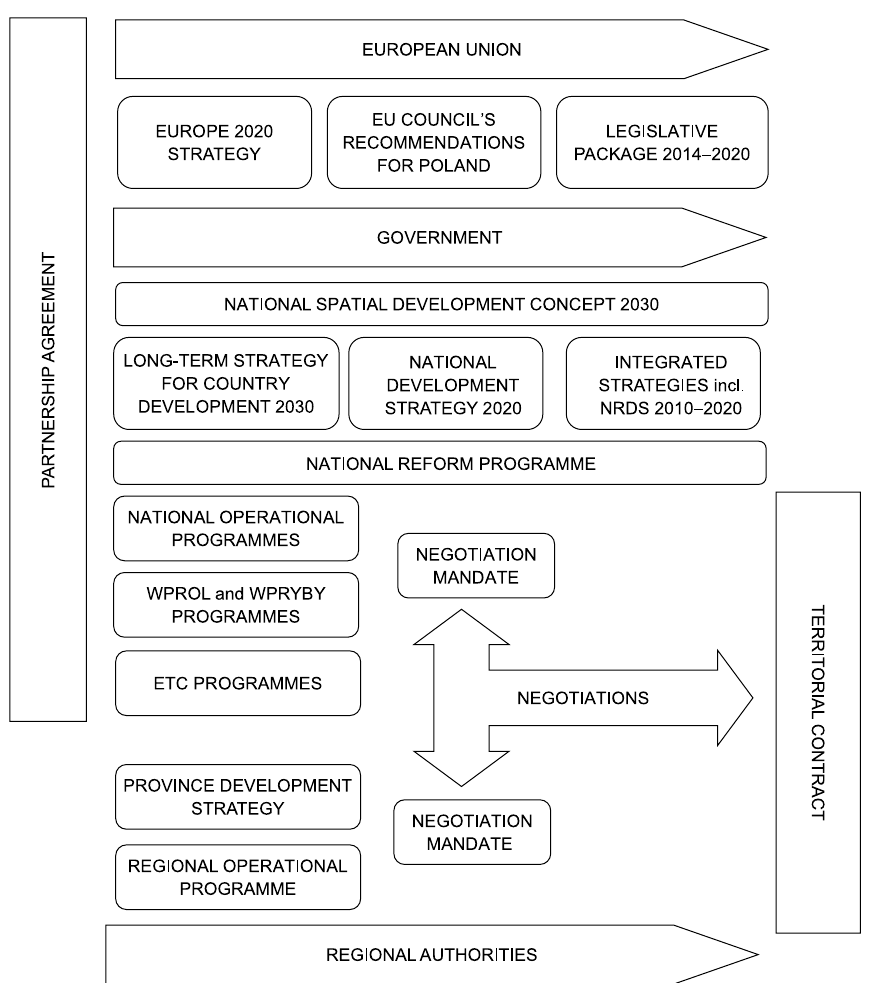
Fig. 2. Operating model of territorial contracts in Poland. Source: own